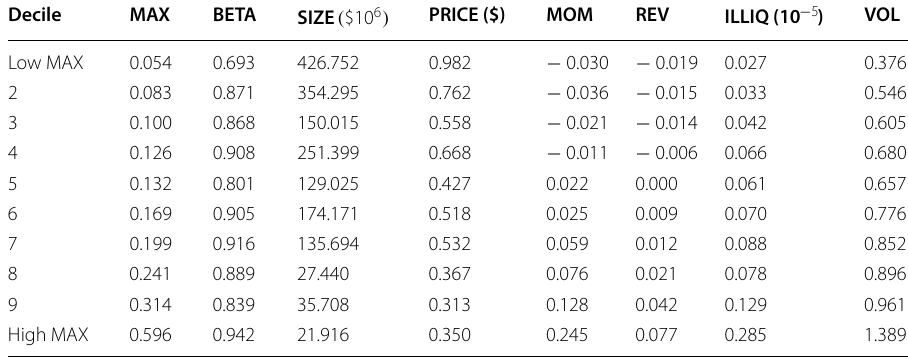
Decile portfolios are formed every week from January 2014 to September 2020 by ranking cryptocurrencies based on the maximum daily return (MAX) within the past month. Decile 1 (10) is the portfolio of cryptocurrencies with the lowest (highest) maximum daily return over the previous month. Table presents the averages of weekly median values of each decile for various characteristics of cryptocurrencies – the maximum daily return (MAX), the cryptocurrency market beta, the market capitalization (in millions of dollars), the price (in dollars), the cumulative return over the previous three weeks prior to the week before (MOM), the cumulative return over the past week (REV), the Amihud illiquidity measure (scaled by 10 − 5 ), and the Garman–Klass volatility